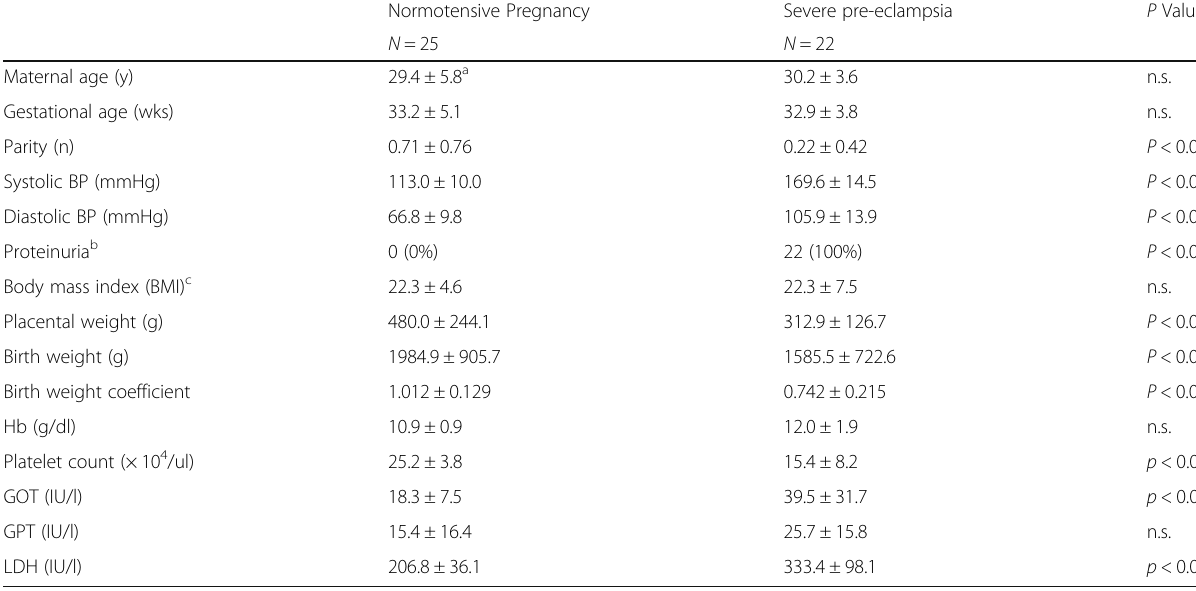
Table 1 Characteristics of the subjects with normotensive pregnancies and severe